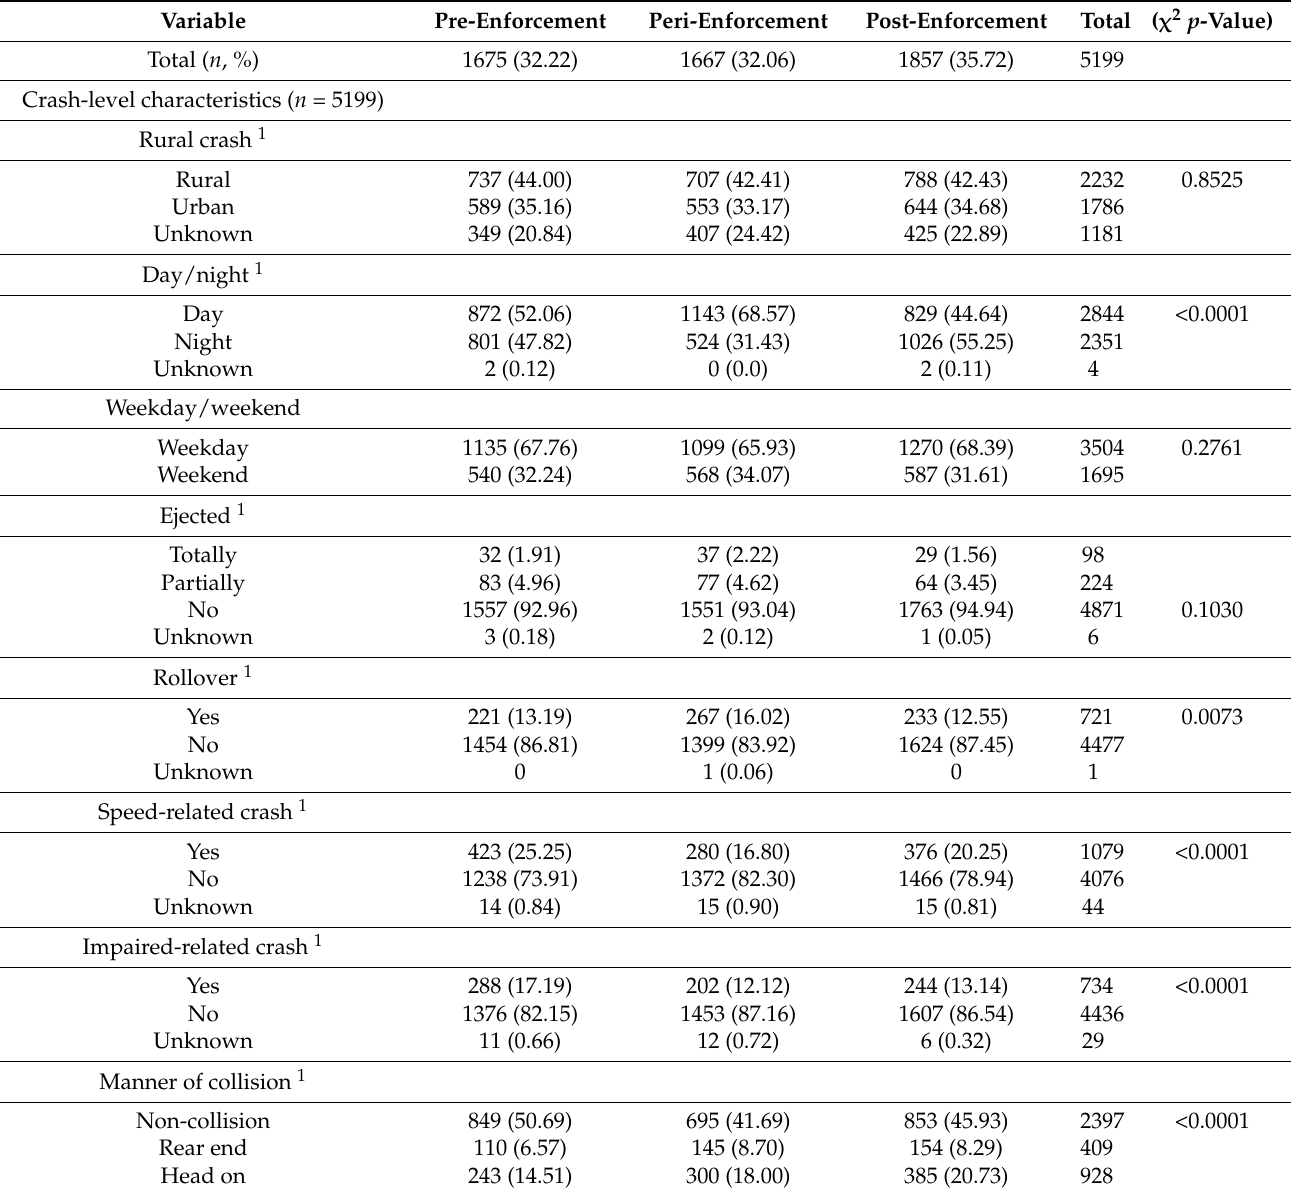
Table 2. Roadway, Vehicle, and Crash Characteristics of Fatal Crashes in the Upstate and Long Island Regions of New York State by Click it or Ticket Enforcement Periods, FARS